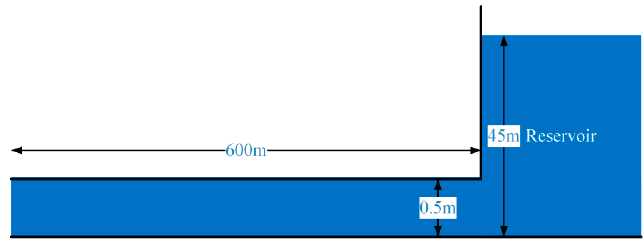
Figure 17. A sketch of the conduct–reservoir model.